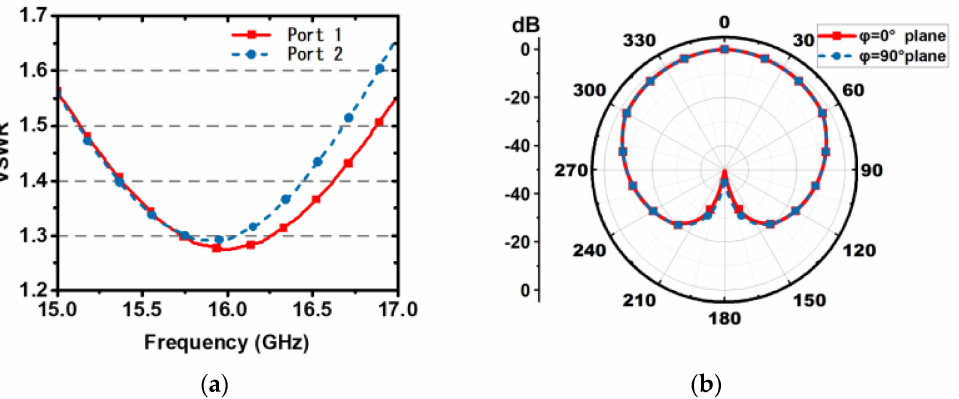
Figure 4. Simulated results of the antenna element in HFSS. ( a ) Simulated VSWRs at Port 1 and Port 2. ( b ) Simulated radiation patterns in the ϕ = 0 ◦ and ϕ = 90 ◦ planes at 16 GHz.